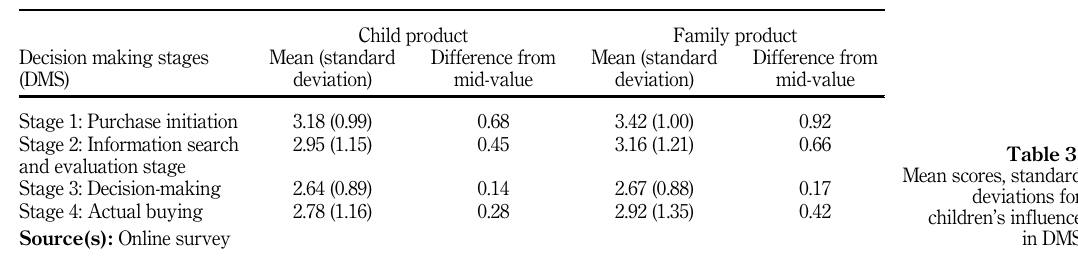
Table 3. Mean scores,